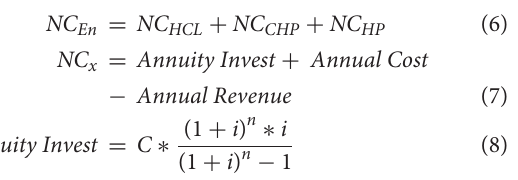
Frontiers in Sustainable Cities |